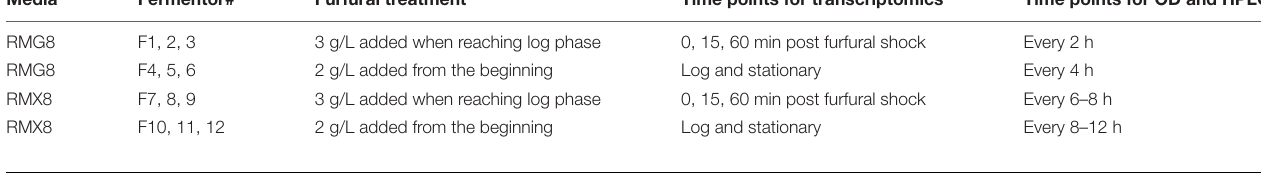
TABLE 1 | Experimental design and sampling time for furfural stress and shock responses.